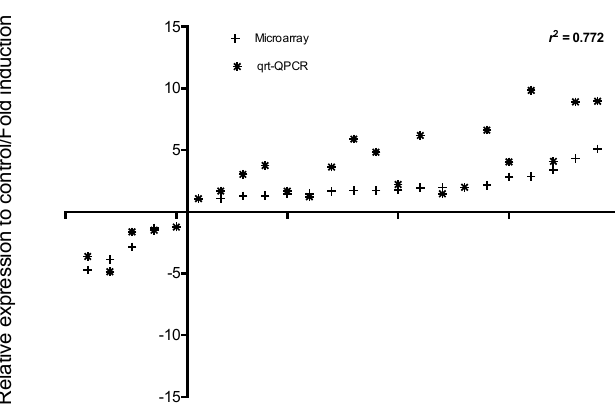
Figure 3. Comparison between microarray and RT-qPCR results. Expression values for the twelve target mRNAs were compared between microarray probes and RT-qPCR data. Ratio between microarray expression values and RT-qPCR was estimated using fold-change. Table 1. Comparison between microarray and RT-qPCR fold change.